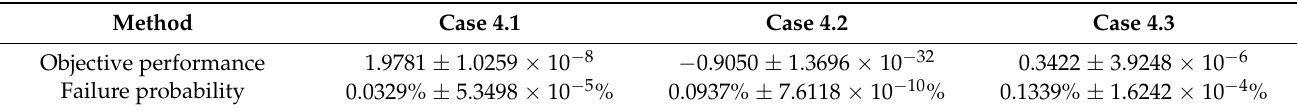
Table 7. Repeated experiment results of cases (number of experiments =